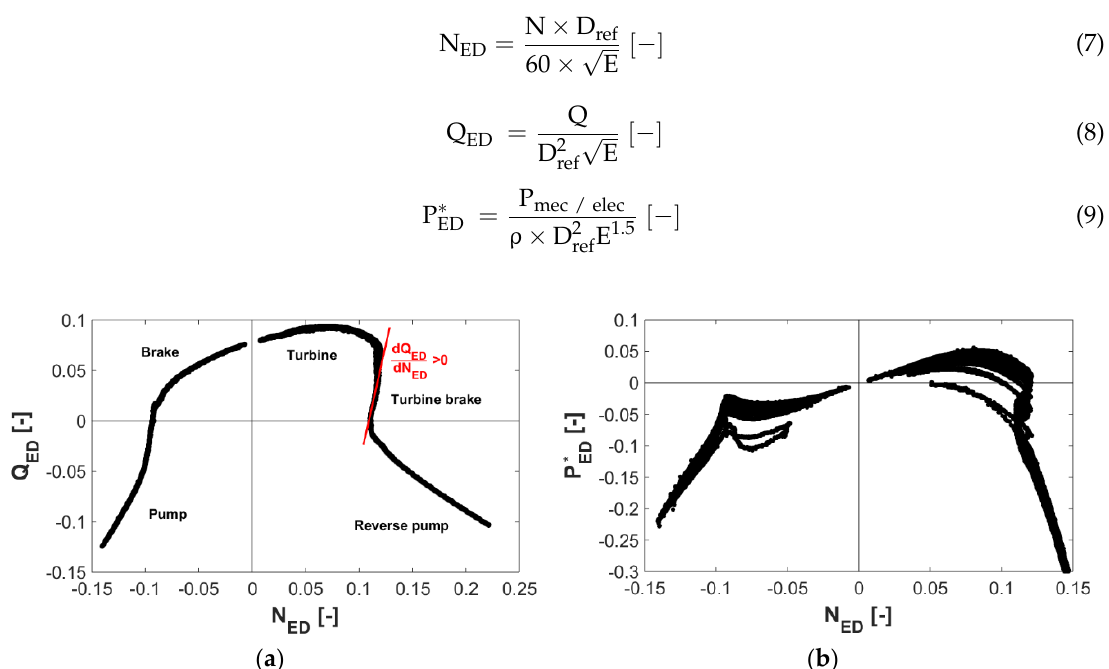
Figure 10. Resulting 4-quadrant characteristic curves of the PAT obtained by the dynamic measurements method: ( a ) speed-discharge factor characteristic curve; ( b ) speed-power factor characteristic